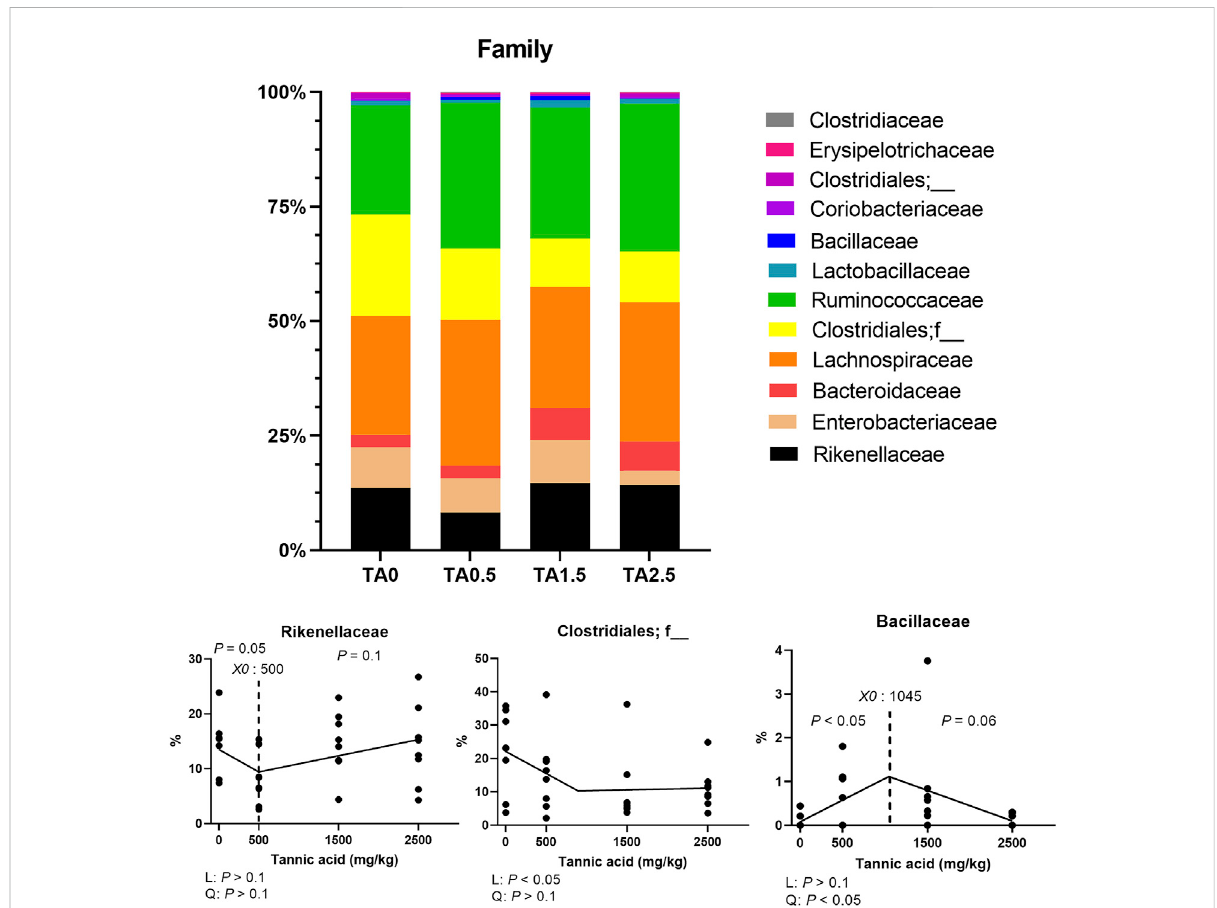
FIGURE 14 Family-level compositionofthececalmicrobialcommunitiesinbroilerchickensfeddifferentconcentrations(0,0.5,1.5,and2.5 g/kg)oftannic acid on D 21. Only families with signi fi cant differences and relatively high relative abundance were presented separately with statistical analyses. The treatment groups were compared using one-way ANOVA followed by the Tukey ’ s multiple comparison. Different superscripts differ at p < 0.05. Orthogonalpolynomialcontrastsanalysis wasconducted toseelinearpattern(L)andquadraticpattern(Q)amongthetreatments. Tocalculate the optimal dosage of tannic acid in broilers, segmented linear regression was conducted, and X0 (in fl ection point) with p values for slope 1 (lower than X0 ) and slope 2 (higher X0) were